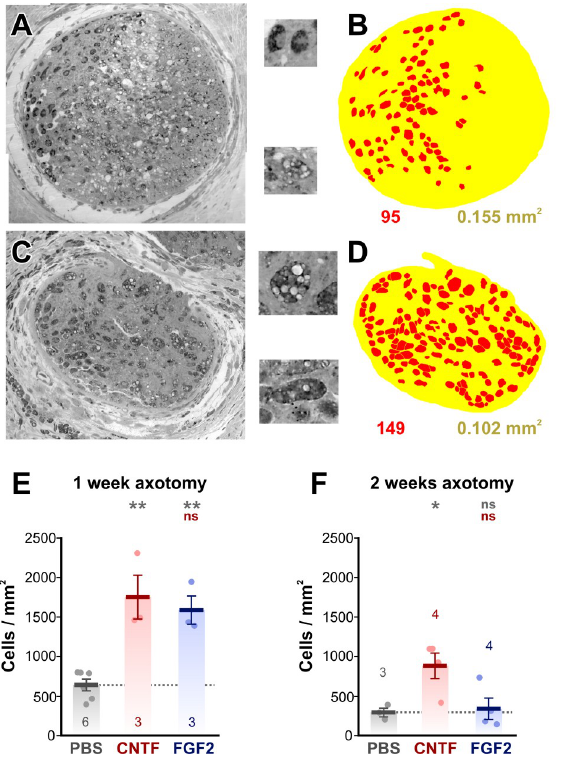
Fig 1. Growth factor treatment increases macrophage numbers. (A and C) Light micrographs of 1 μ m resin sections of optic nerves, taken 100 μ m distal to the crush zone. A is a PBS-treated control, C is from a CNTF-treated animal. The insets show enlarged examples of macrophage cell profiles, showing dark staining, granules, and vacuoles. (B and D) Color overlays of the light micrographs, delineating macrophage cell profiles (red) and the nerve itself (yellow). The cell count and nerve area derived from these overlays are shown below. (E and F). Combined scatterplots and barcharts of cell density showing mean ± SEM. Asterisks or “ns” above each column indicate the significance when compared to PBS (row 1, gray) or CNTF (row 2, red) with ANOVA and post-hoc Tukey tests. (E) At 1 w after nerve crush there are increases in cell density with CNTF and FGF-2 treatment, compared to PBS-treated controls. (F) 2 weeks after crush, only CNTF treatment shows an